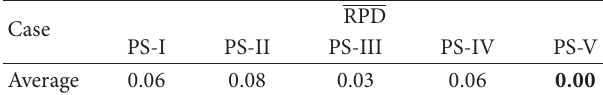
Table 10: Comparisons of different population sizes.